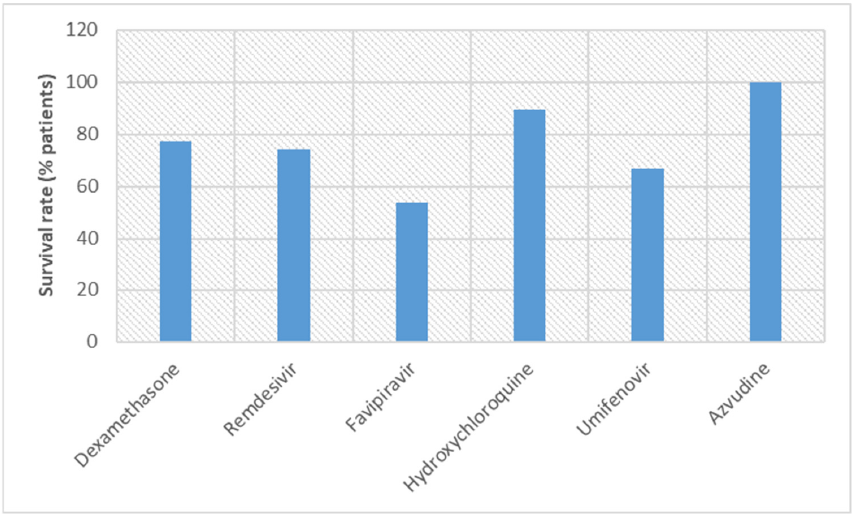
Figure 4. Comparison of survival rates of COVID-19 patients in clinical trials conducted with repurposed drugs.